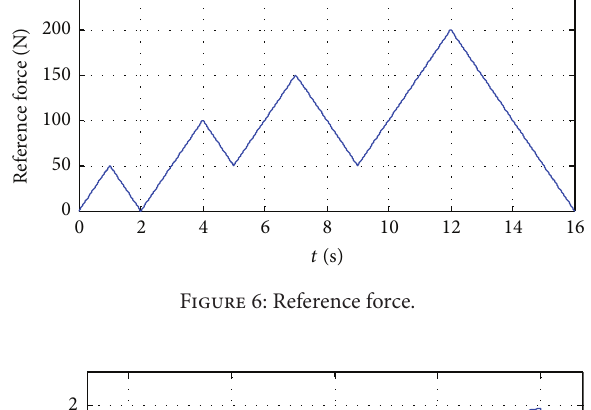
Figure 6: Reference force.